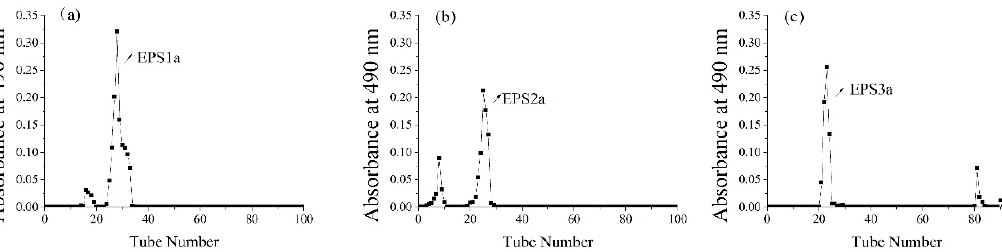
Figure 2. The elution curve of EPS1 ( a ), EPS2 ( b ), and EPS3 ( c ) on G-100. The carbohydrates were detected via UV absorption at 490 nm. The eluent solvent was distilled water.